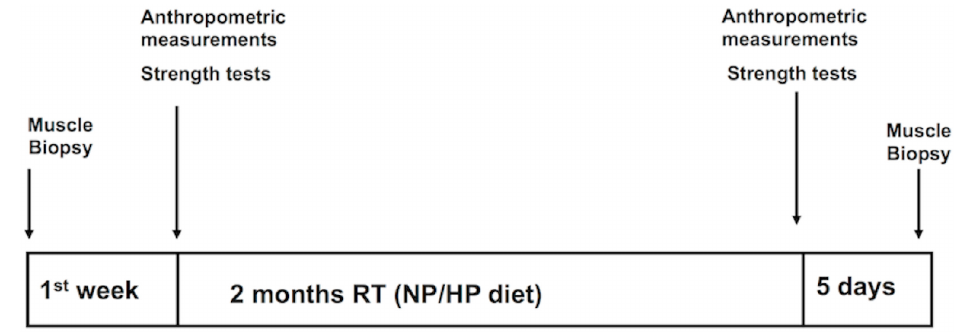
Figure 1. Experimental design. LDM = latissimus dorsi muscle; RT = resistance training; NP = normal protein diet; HP = high protein diet.